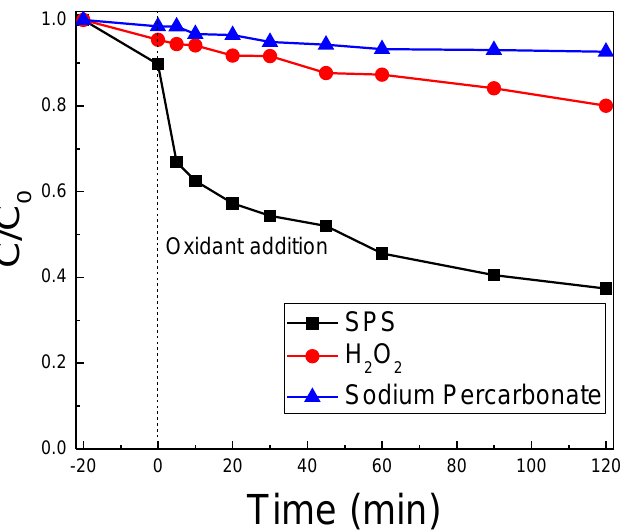
Figure 10. Effect of different oxidizing agents on 500 μg L −1 SMX degradation with 500 mg L −1 RHB700 in UPW and inherent pH.